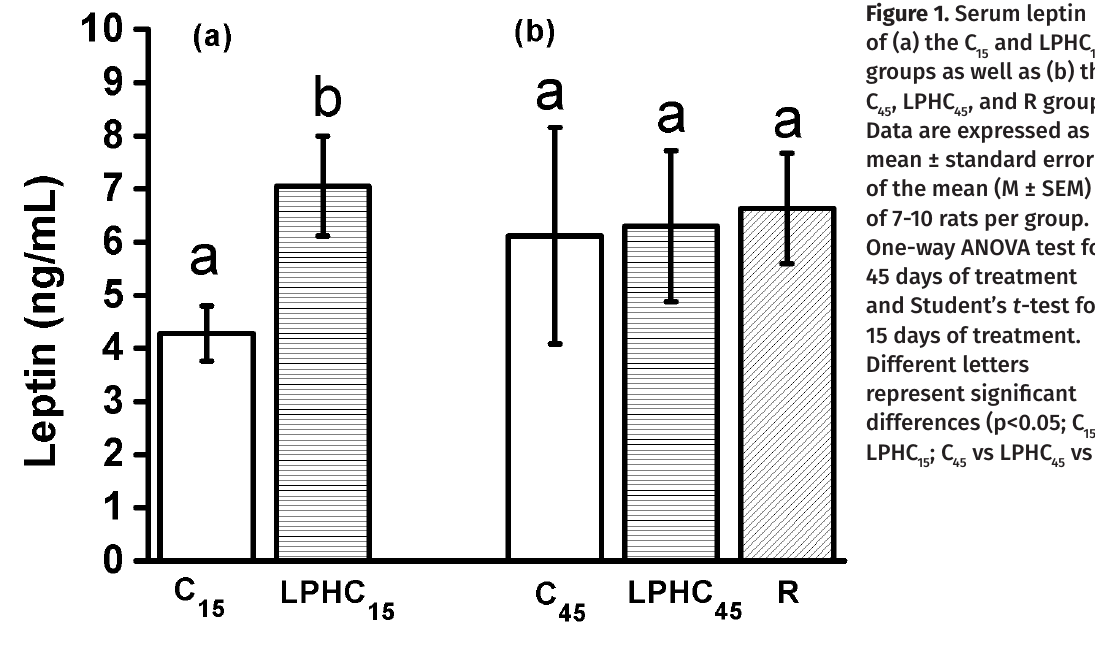
Figure 1. Serum leptin of (a) the C and LPHC 15 15 groups as well as (b) the C , LPHC , and R groups. 45 45 Data are expressed as mean ± standard error of the mean (M ± SEM) of 7-10 rats per